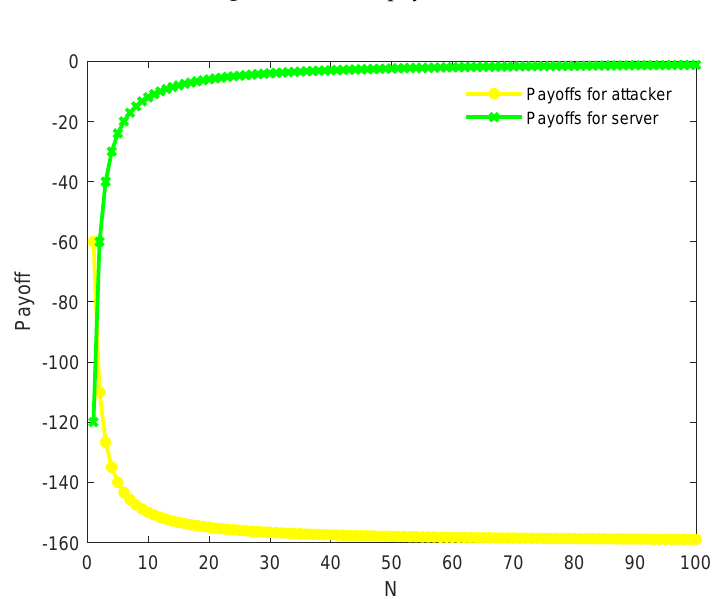
Figure 11. All the payoff curves.